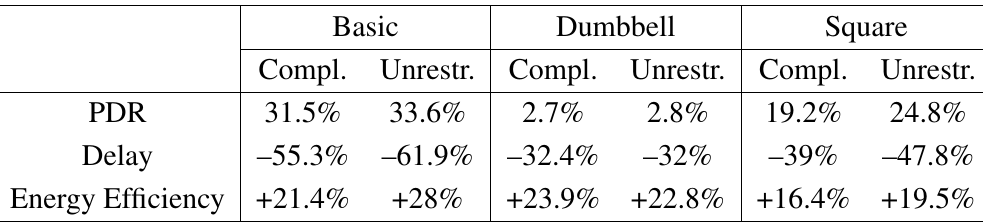
Table 5. Performance improvements achieved by the recommended stack configurations over the default ZigBee stack configuration for different topologies (default transmission power, high traffic scale).